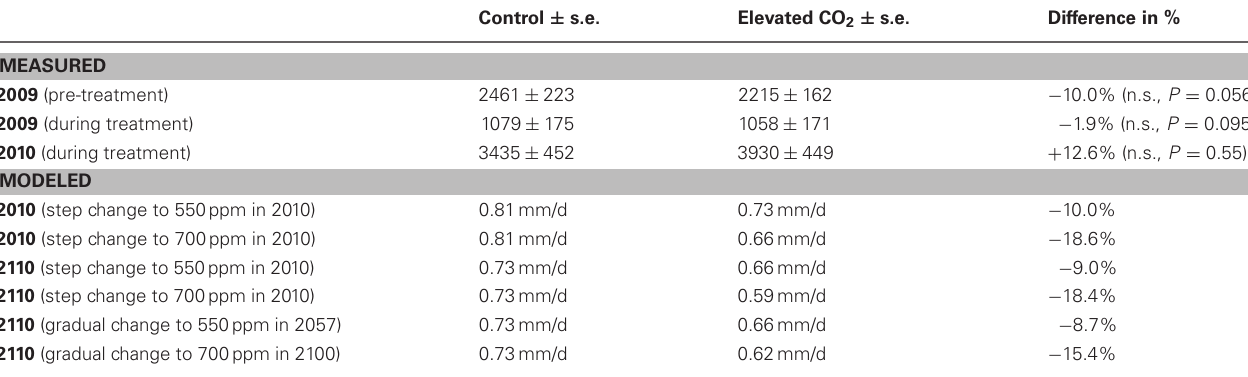
Table 1 | Comparison of measured and modeled transpiration under control and elevated CO 2 conditions, estimated from relative sap flow in P. abies in the experiment, and from total stand transpiration of evergreen needle-leaved trees in the dynamic global vegetation model LPJ-GUESS.